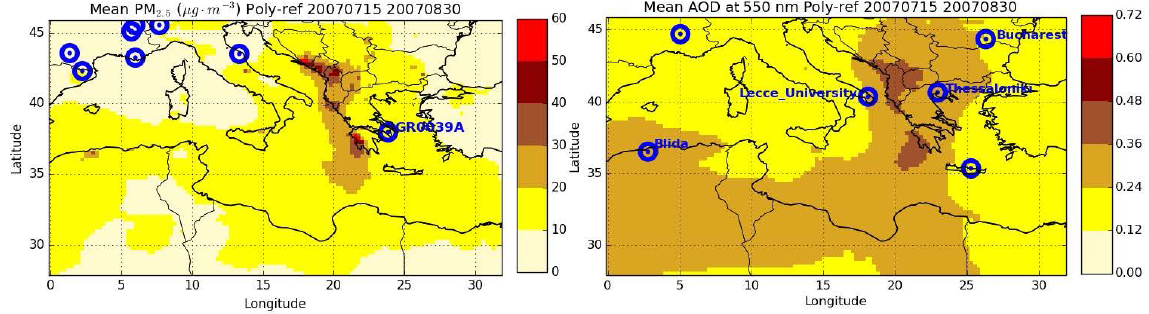
Figure 3. Daily mean surface PM 2 . 5 and AOD at 550nm from the Poly-ref simulation averaged over the summer of 2007 (the eight AIRBASE and six AERONET stations, used in this work, are represented here in blue dots).